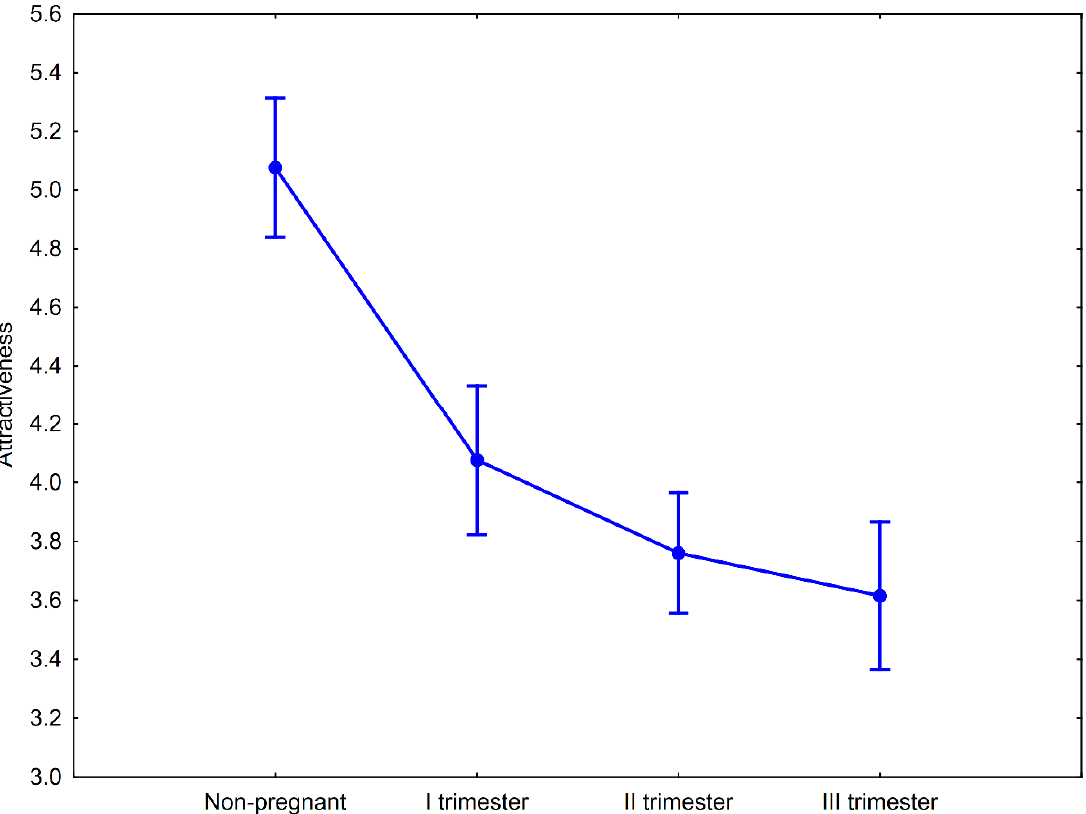
Figure 2. Mean attractiveness ratings of nonpregnant and pregnant women at the three stages of pregnancy. Whiskers represent 95% confidence intervals.